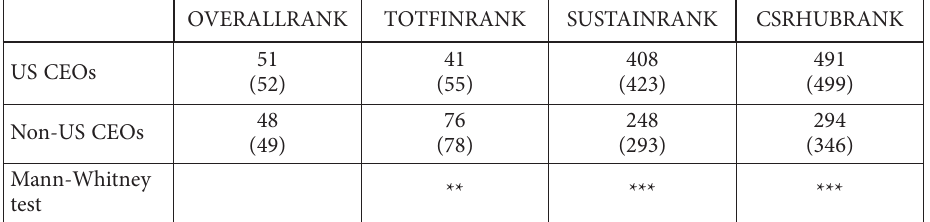
Panel B: Median (mean) positions in rankings for US and non-US CEOs OVERALLRANK TOTFINRANK SUSTAINRANK CSRHUBRANK US CEOs